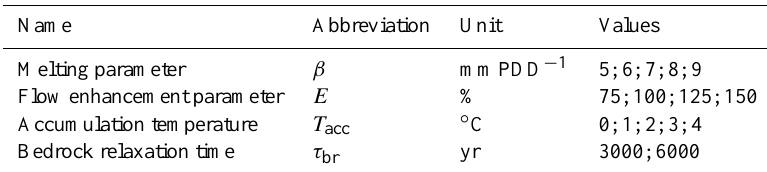
Figure 4. Results of the EISMINT fixed (left) and EISMINT freemargin (right) comparison at a steady state around 200000 simulated years. Both images show ice surface elevation of the IceBern2D model with contour lines of 200m equidistance. The EISMINT fixed is identical with the test from Huybrechts et al. (1996); the peak is in the center of the grid at an elevation of 3342.6m. EISMINT freemargin has a deviation of 1% from Huybrechts et al. (1996); the peak in the center is at 2925m. Table 3. Four tuning parameters with their used values. All possible combinations of parameter values result in 200 experiments which are run with two different versions of LGM climate